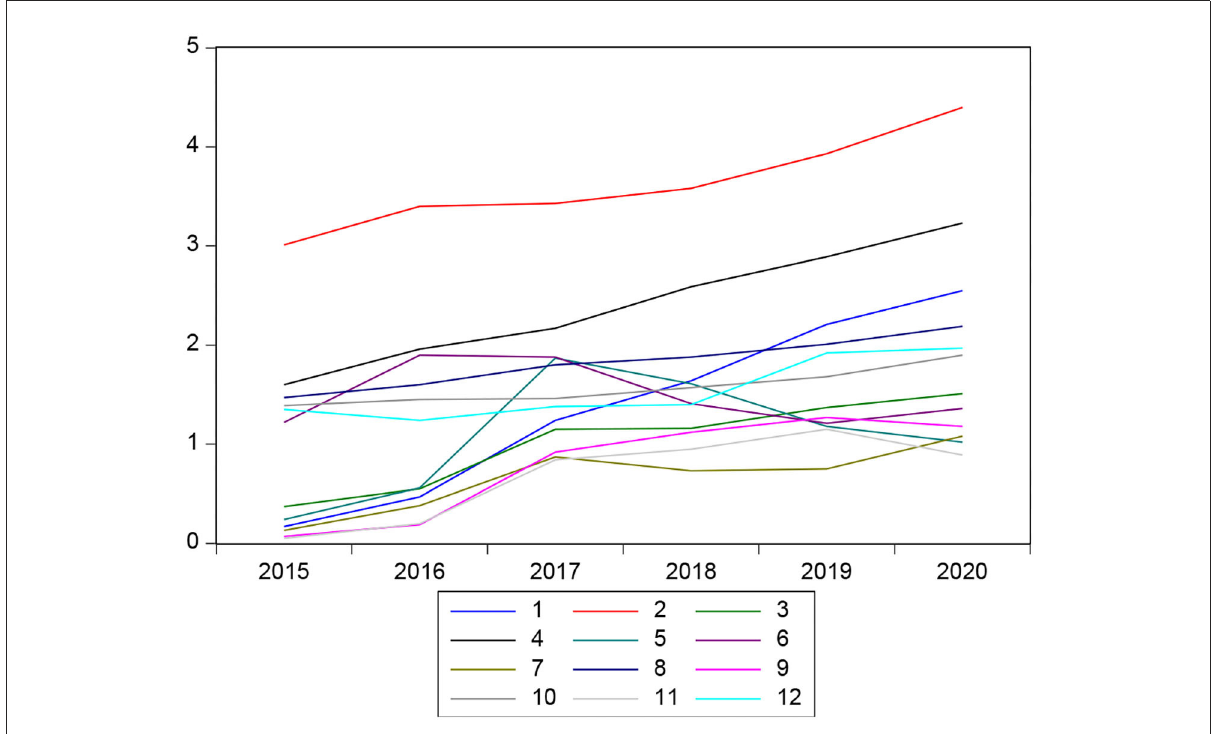
FIGURE6 Change in gross domestic product